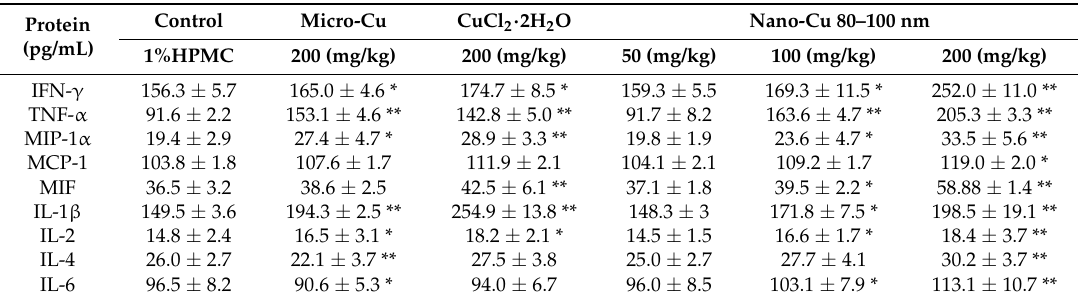
Table 5. Expression levels of proteins associated with inflammation in rats treated with copper sources by oral administration over 28 consecutive